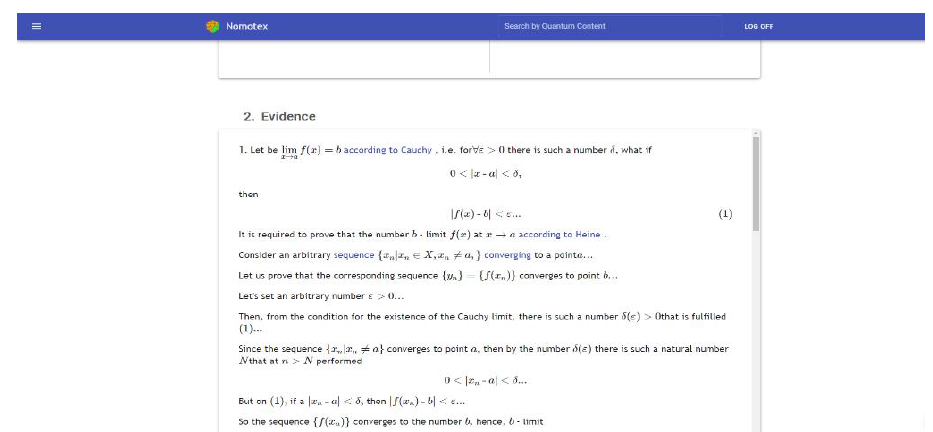
Fig. 4. Window of the «Implementation of neural network programs» subsystem in the Nomotex DLS. Course «Mathematical analysis», paragraph «The concept of the limit of a function», lecture 8, quantum Equivalence of definitions according to Cauchy and Heine. Proof of the theorem.